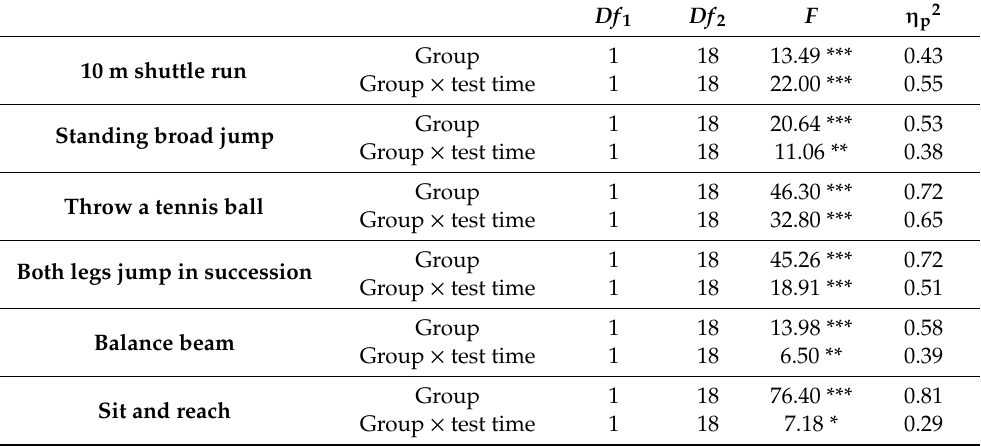
Table 2. Results of repeated ANOVA of 2 (group: experimental group and control group) × 2 (test time: pre-test and post-test) for six indexes of the physical fitness.